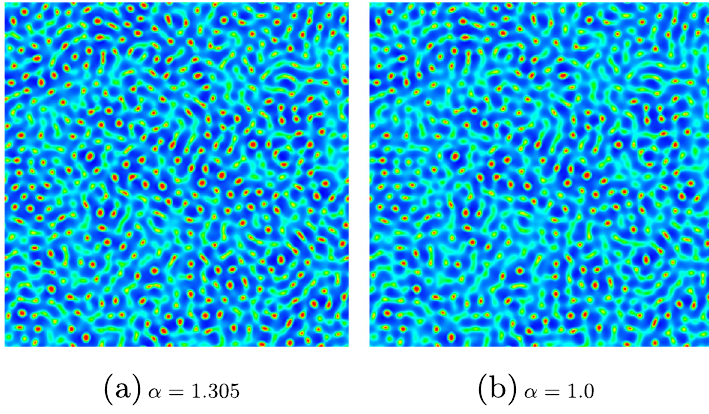
Fig. 11 Snapshots of the spinodal decomposition process, τ = 0.3 , T r = 0.8 , t =